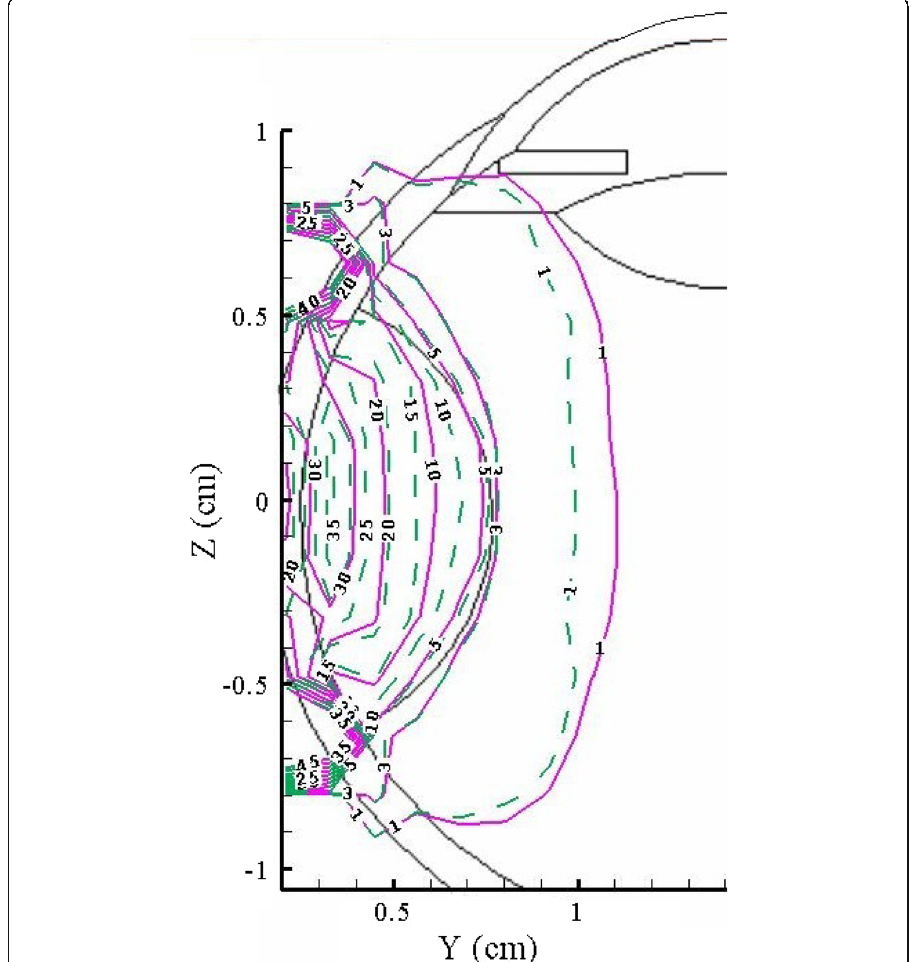
Fig. 6. The isodose curves for the homogeneous model (solid lines) and heterogeneous model (dashed lines) in the depth of eye phantom including a tumor loaded with 100 nm GNPs of 30